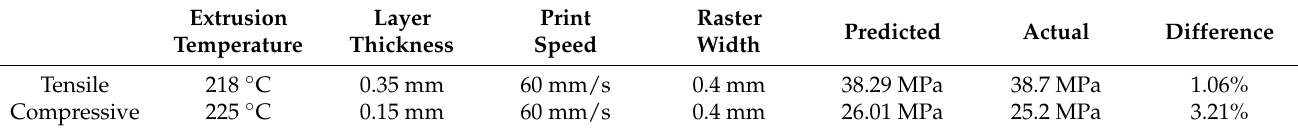
Table 8. Confirmation experiment for